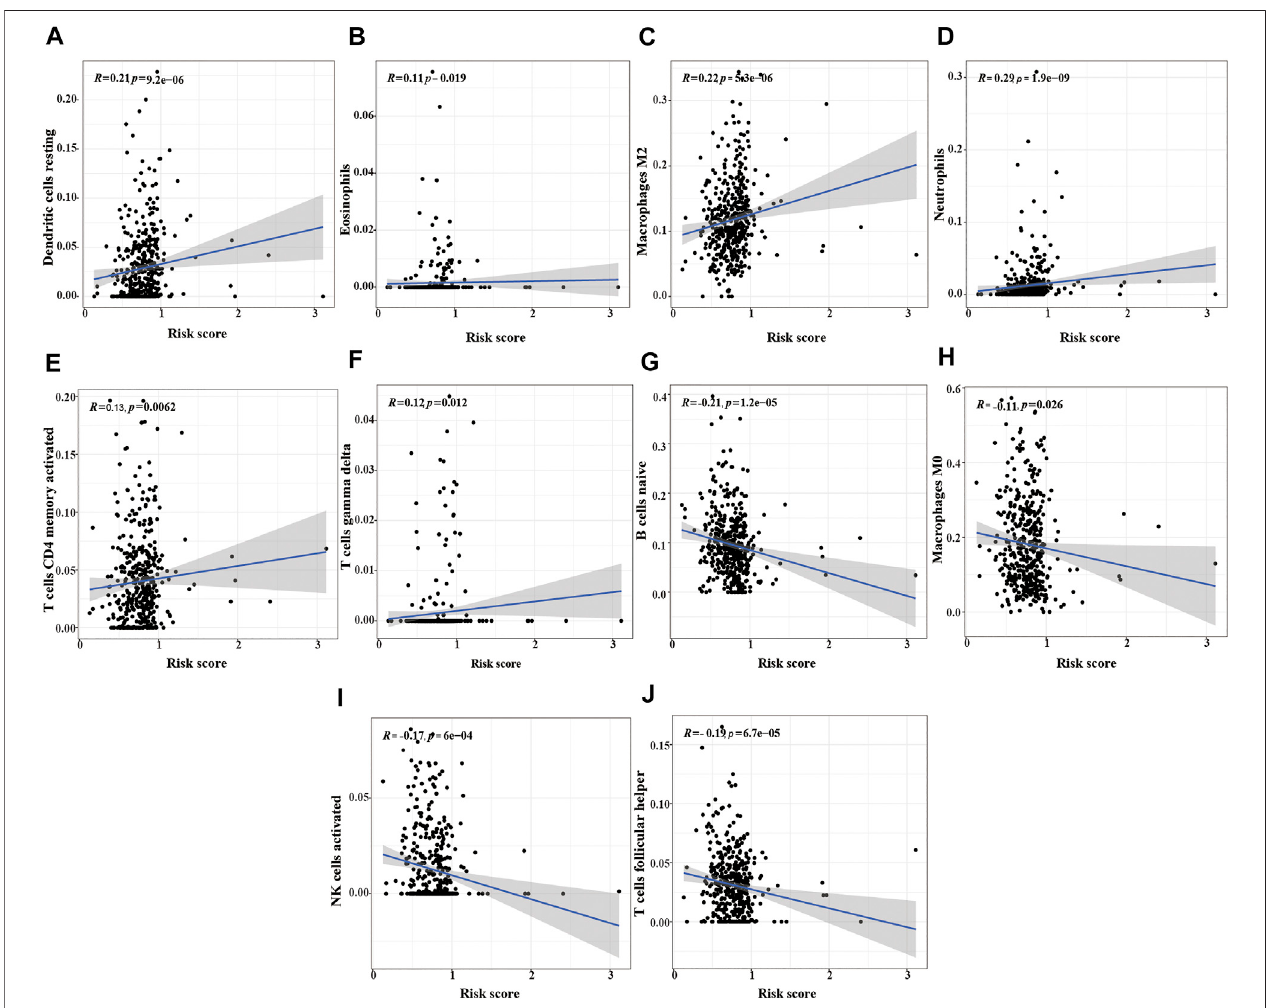
FIGURE11| Thecorrelationanalysisbetweentheriskscoreandimmunecells. (A) restingdendriticcells, (B) eosinophils, (C) M2macrophages, (D) neutrophils, (E) activated CD4 memory activated cells, (F) gamma delta T cells, (G) naïve B cells, (H) M0 macrophages, (I) activated NK cells, (J) follicular helper T cells.